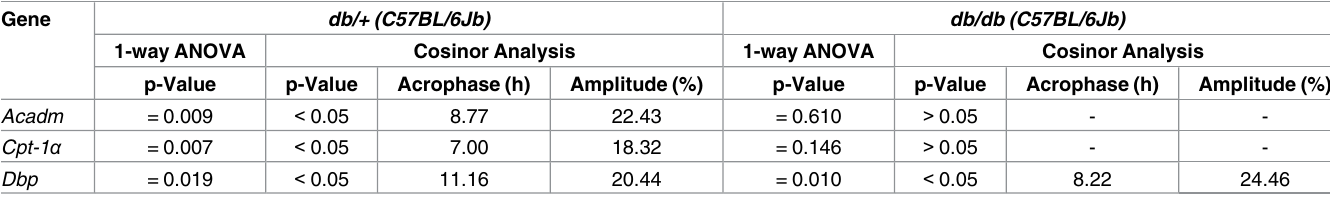
Table 4. Statistical analysis of transcriptional profiling illustrated in Fig 4. Gene db/+ (C57BL/6Jb) db/db (C57BL/6Jb) 1-way ANOVA Cosinor Analysis 1-way ANOVA Cosinor